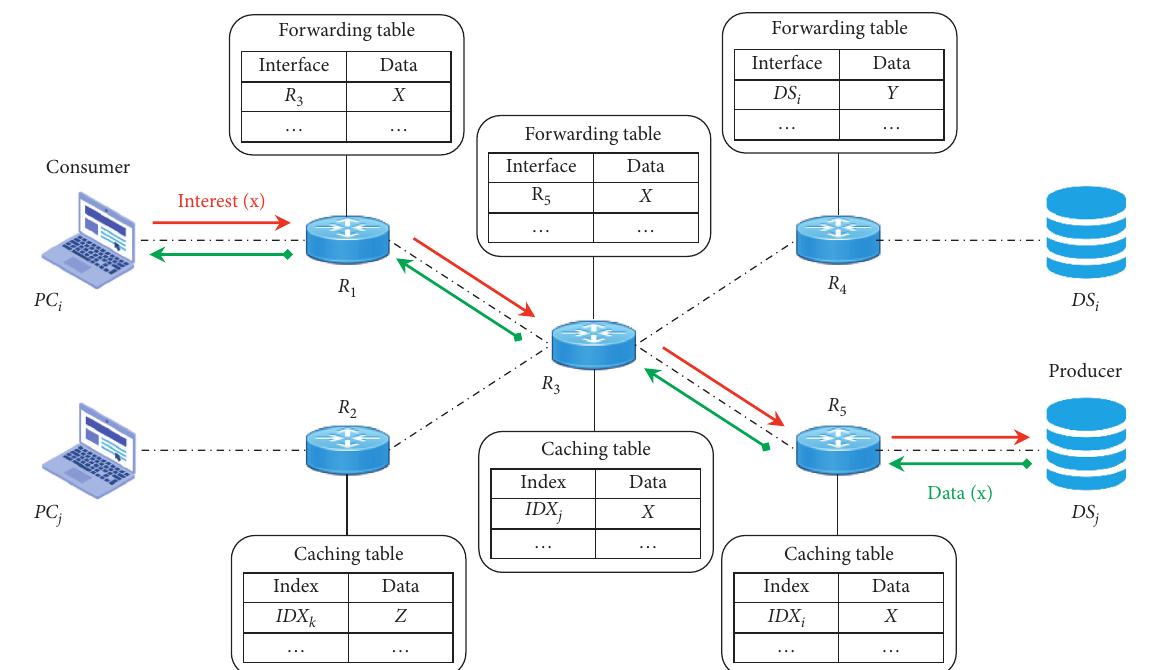
Figure 1: NDN communication